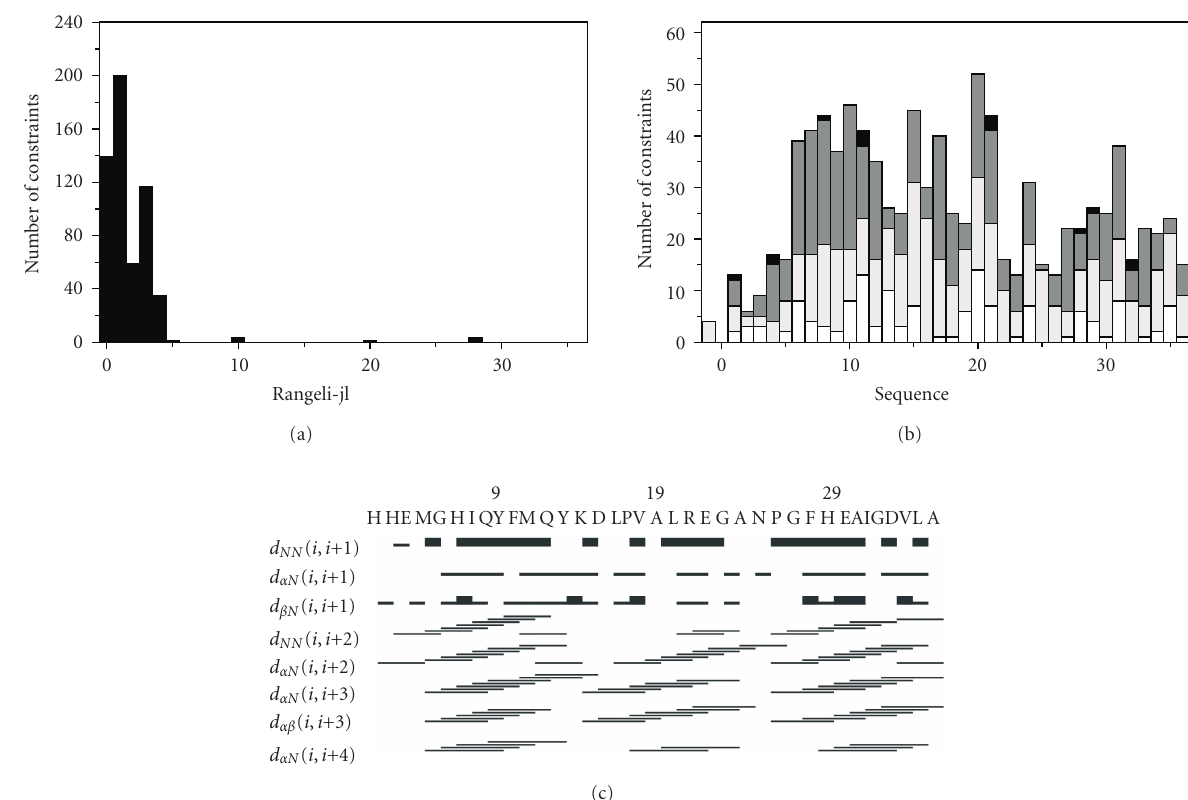
Figure 3: (a) Short-, medium-, and long-range connectivities. (b) Number of NOE constraints per residue (white, gray, dark gray, and black vertical bars represent, resp., intraresidue, sequential, medium-range, and long-range connectivities). (c) Schematic representation of the sequential and medium range NOEs involving HN, H α , and H β protons for Zn 2+ -ACE C (37) (corresponds to His 958 -Ala 994 of the human somatic